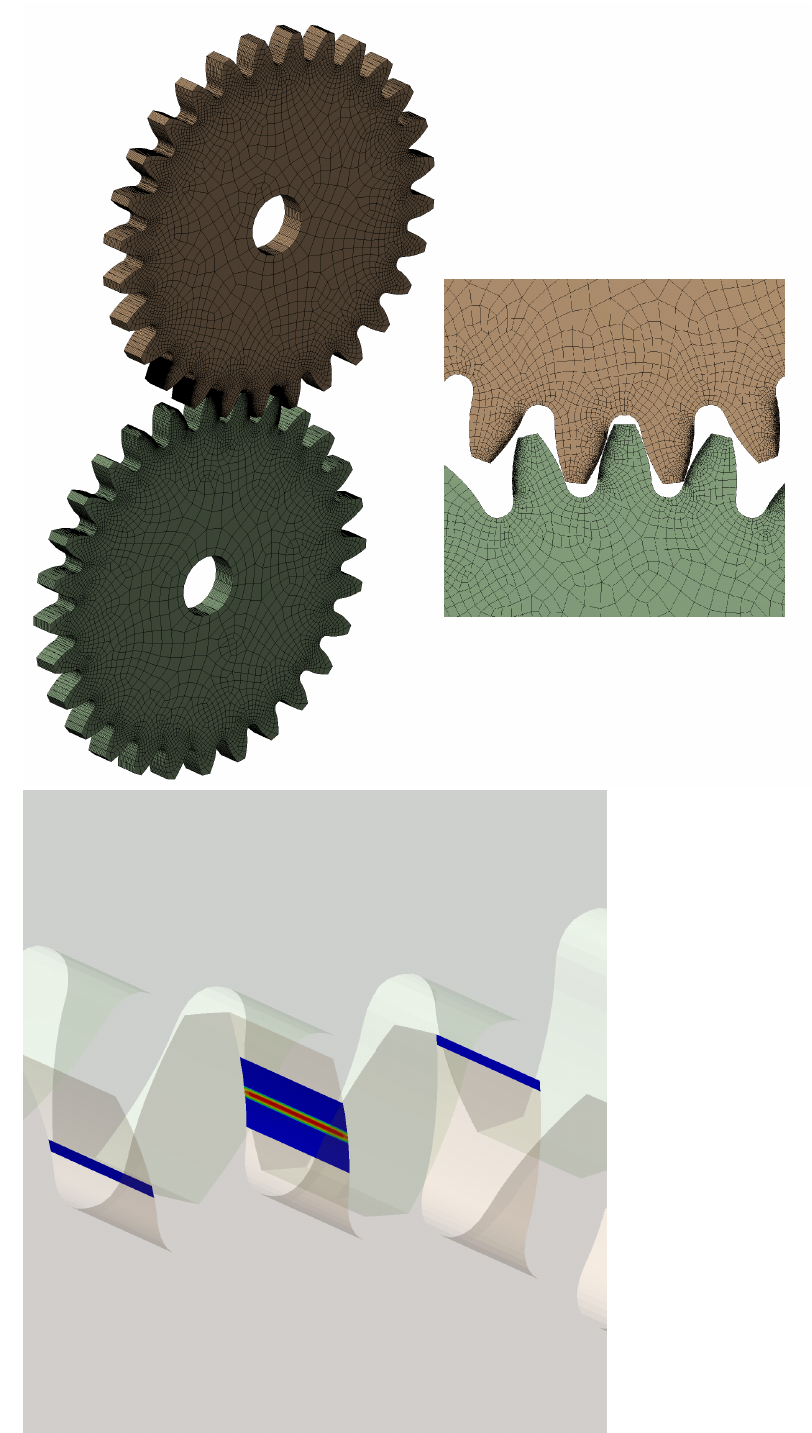
Figure 11. Mesh of the solid model and pressure results from